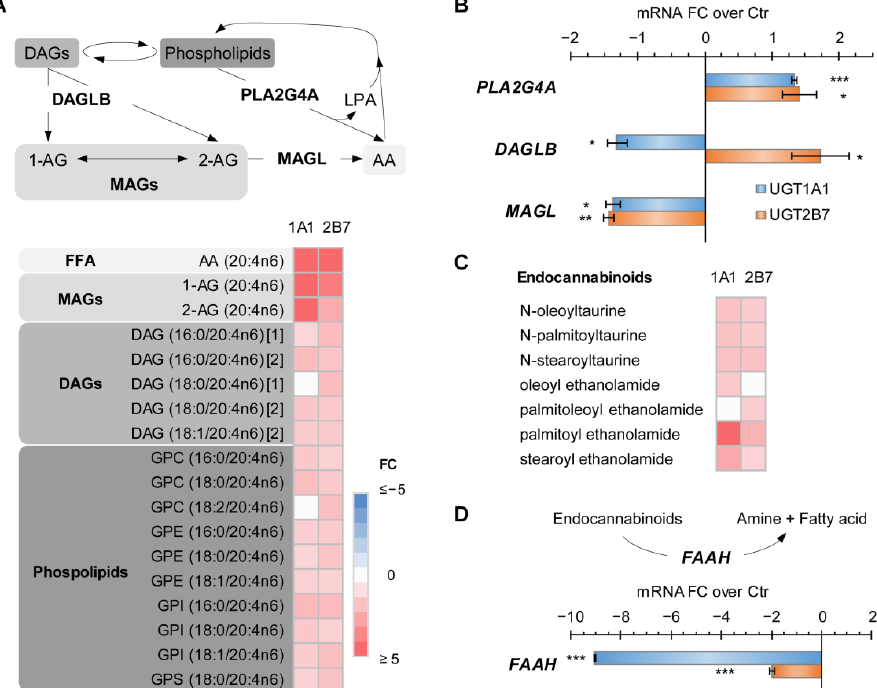
Figure 4. UGT1A1 and UGT2B7 enzymes induce an accumulation of bioactive lipids. ( A ) Arachi- donic acid (AA; C20:4n6) and its precursors, 1-arachidonoylglycerol (1-AG) and 2-AG, are elevated in cells expressing UGT1A1 and UGT2B7 enzymes, whereas the levels of these metabolites are almost unaffected by the expression of alt. UGT1A1 and alt. UGT2B7 (Table S2). MAG, monoacyl- glycerol; DAG, diacylglycerol; GPC, glycerophosphocholine; GPE, glycerophosphoethanolamine; GPI, glycerophosphoinositol; GPS, glycerophosphoserine; LPA, lysophosphatidic acid. MAGL, monoacylglycerol lipase; DAGLB, diacylglycerol lipase B; PLA2G4A, cytosolic phospholipase A2 group IV A. Lipid species are detailed in parentheses. ( B ) The accumulation of AA is linked to an increased expression of PLA2G4A and repressed expression of MAGL in enzyme-expressing cells, as detected by reverse-transcriptase-quantitative-PCR (RT-qPCR). DAGLB expression did not cor- relate with levels of AA-containing lipids. mRNA fold change (FC) over control (Ctr) cells is dis- played. ( C ) Enrichment of endocannabinoids in UGT enzyme-expressing cells. ( D ) The expression of the fatty acid amide hydrolase (FAAH), catalyzing the hydrolysis of endocannabinoids, was decreased in enzyme-expressing cells. Metabolite fold changes (FC) relative to control cells are provided in heatmaps. Non-significant metabolites are displayed in white. *** p < 0.001, ** p < 0.01, * p < 0.05.